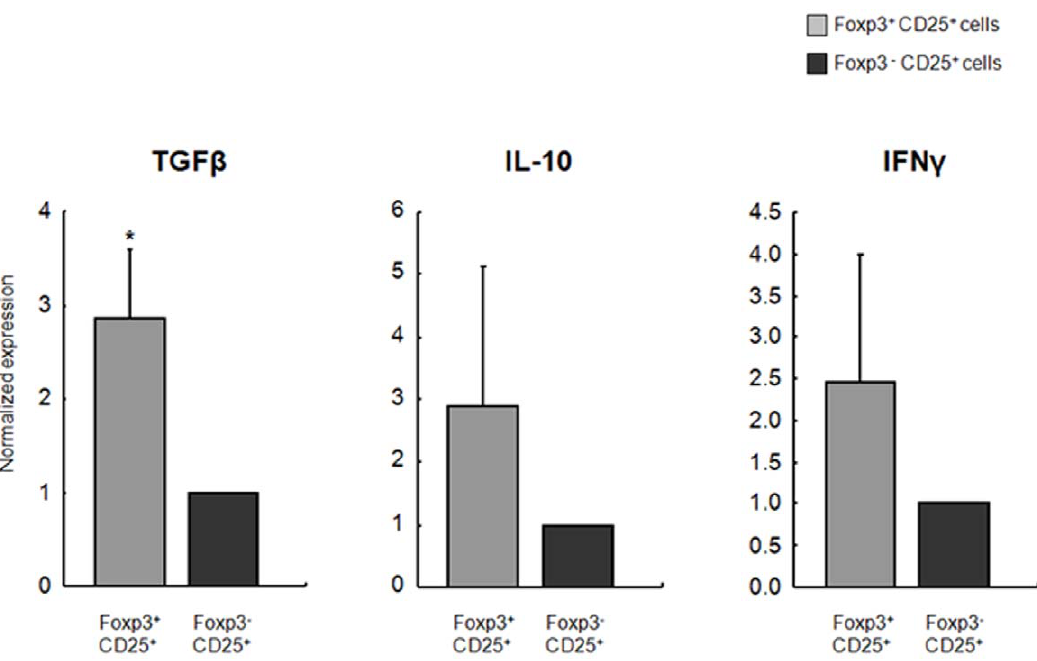
Figure 5. Cytokine mRNA Expression by Foxp3 + CD25 + and Foxp3 2 CD25 + T-cells from long term survivors. Message levels of TGF b , IL-10 and IFN c in CD4 + Foxp3 + CD25 + T-cells obtained from spleens of long term survivors (DSTx4 + LTx rats; survival . 100 days) were quantified and compared to those expressed by CD4 + Foxp3 2 CD25 + T-cells obtained from these same animals. Quantitative Real-time (RT)-PCR was used to quantify cytokine mRNA expression in each population. HRPT was used as an endogenous control to normalize each sample. Data represent mean 6 SD. * P , 0.05 compared with Foxp3 2 CD25 + T-cells. N=5 for each group.